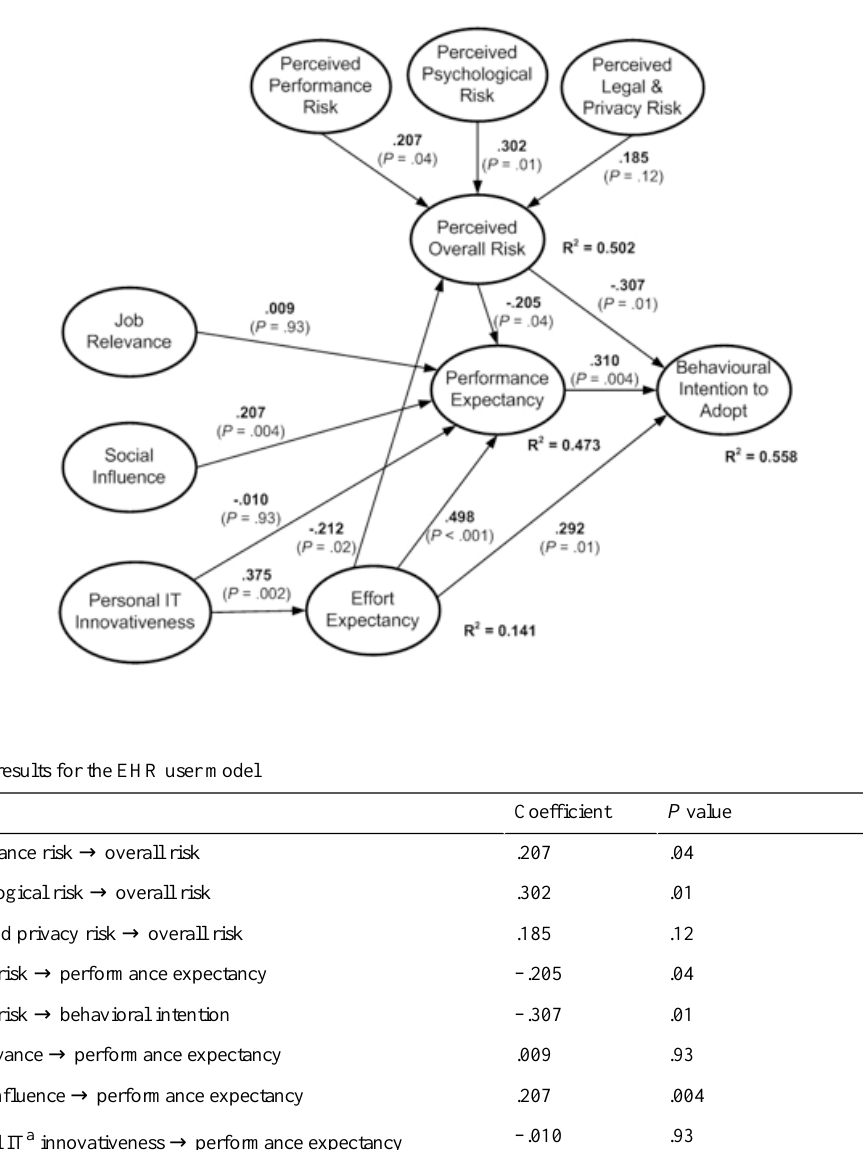
Figure 2. Structural evaluation of the electronic health record user model